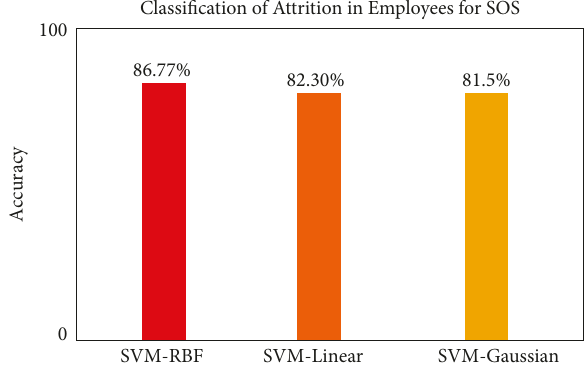
Figure 9: Performance of SVM.